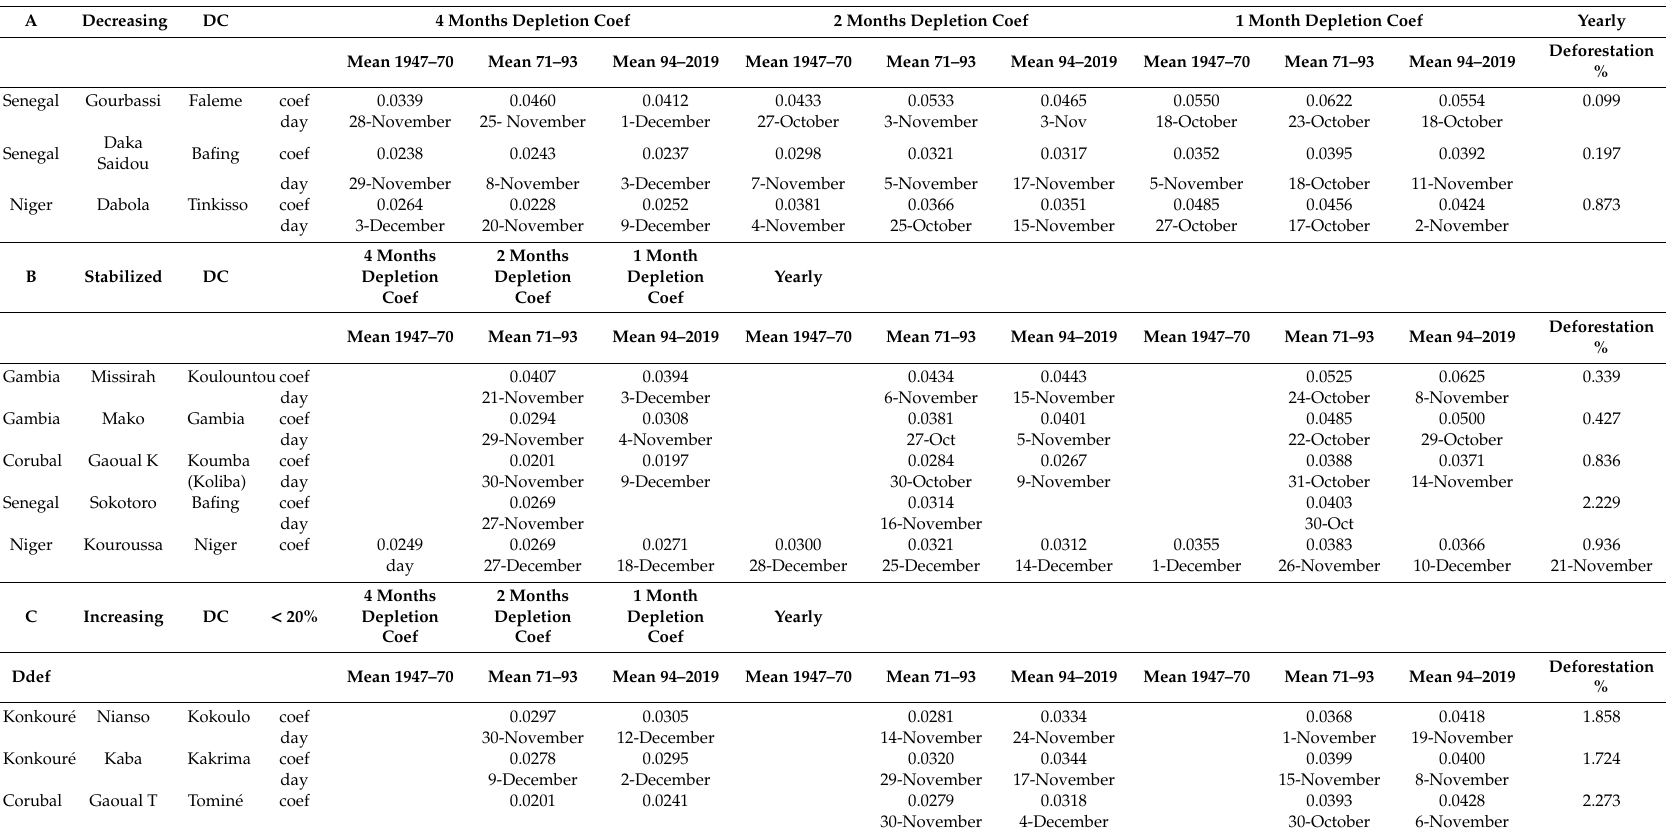
Table 2. Depletion coe ffi cient by basins, by periods, and for di ff erent